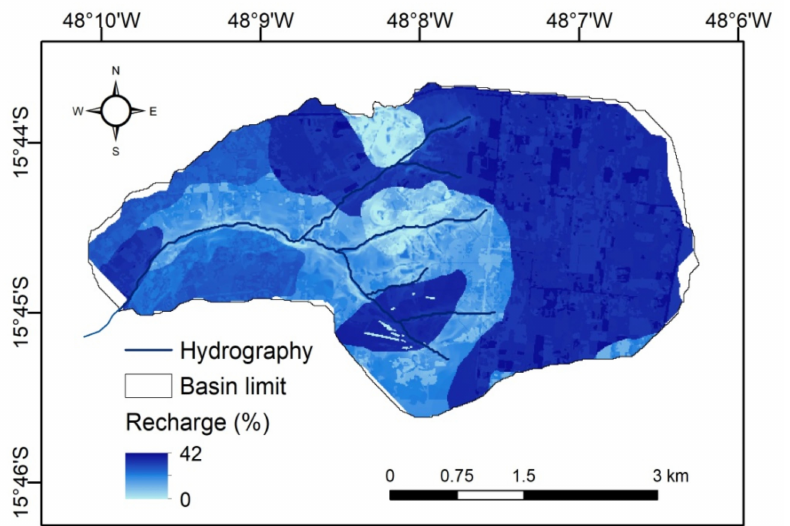
Figure 11. Estimated spatial distribution of potential groundwater recharge: Distributed hydrological